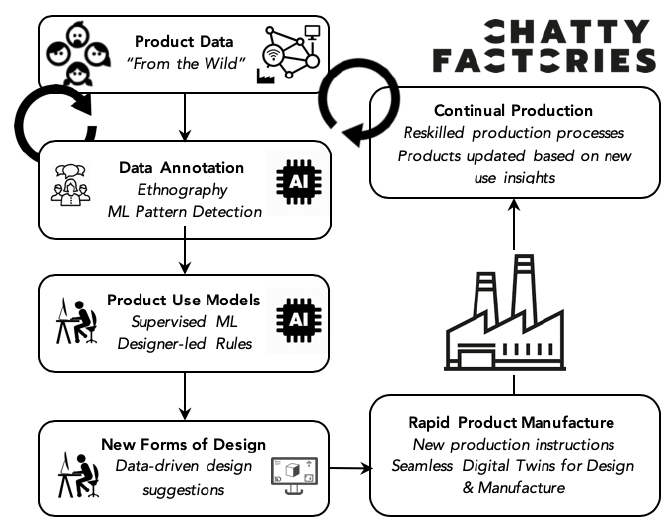
Figure 1. The Chatty Factories